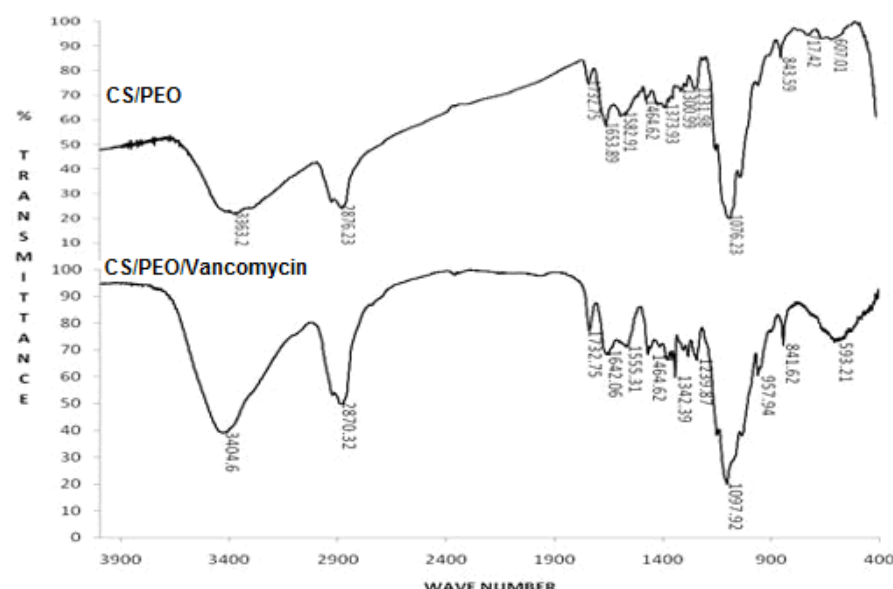
Fig. 3. FT-IR spectrum of CS/PEO nanofiber with and without vancomycin Fig. 3 FT-IR spectrum of CS/PEO nanofiber with and without vancomycin